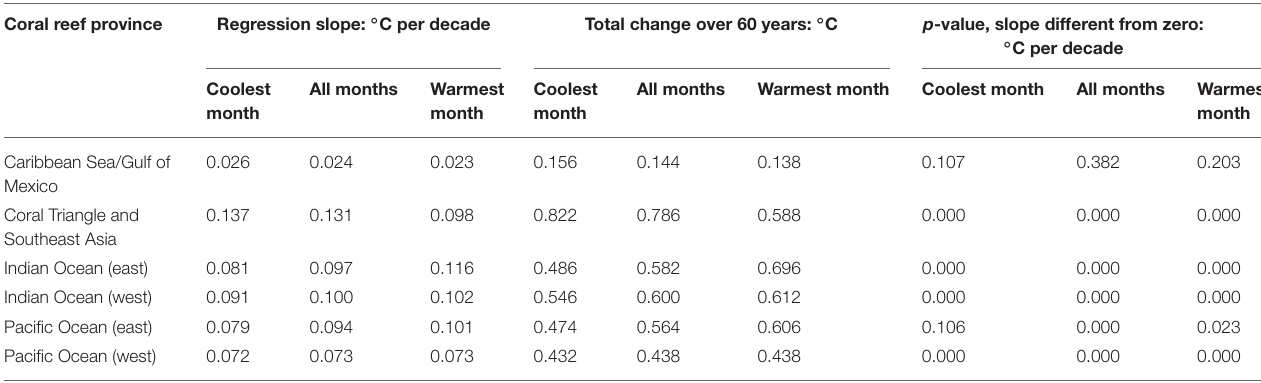
The table includes the slope of the regression ( ◦ C per decade), the p-value for the slope being different from zero and the total change over 60 years (i.e., the slope of linear regression multiplied by six decades) for each category. The p-values that exceed 0.05 plus the associated slope and change values have a gray background, denoting the lower statistical confidence in the slope being different from zero (no slope). Note that changes with higher p-values may still describe informative trends even though the level of confidence that the slopeisdifferent fromzeroislower.FullmethodsgiveninTable30-1inHoegh-Guldbergetal.(2014),reprintedwithpermissionoftheUnitedNationsIntergovernmental PanelonClimate Change, IPCC